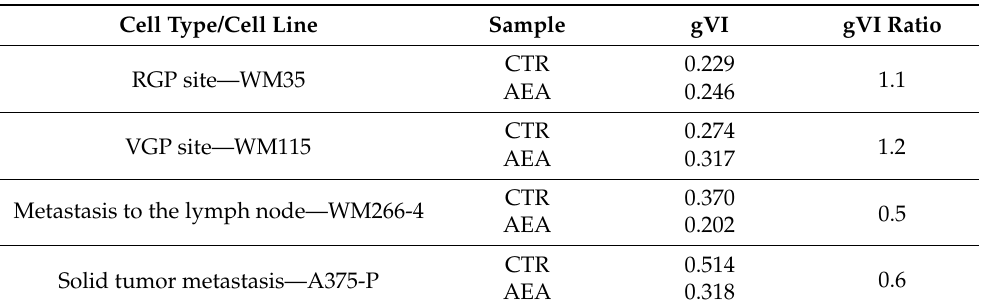
Figure 7. Df plots received for the 6.4 µM Con A concentration of the lectin-glycan interaction performed on AEA-treated melanoma RGP cells ( A )—WM35), VGP cells ( B )—WM115), metastasis to the lymph node ( C )—WM266-4) and solid tumor metastatic cells ( D )—A375-P). ( E )—Overview of the obtained viscoelastic index values for Con A concentrations (1.6–12.8 µM) interacting with glycans of melanoma cells treated with AEA. The statistical significance of the p -value below 0.05 (*) was marked on the graph. Table 3. Results of the glycan viscoelastic index analysis of the AEA-treated melanoma cells received from the QCM-D measurements. The gVI value equal to the tangent of the angle made by the estimated linear regression for the data present on the Df plots. The gVI ratio was calculated as the AEA/DMSO relation.